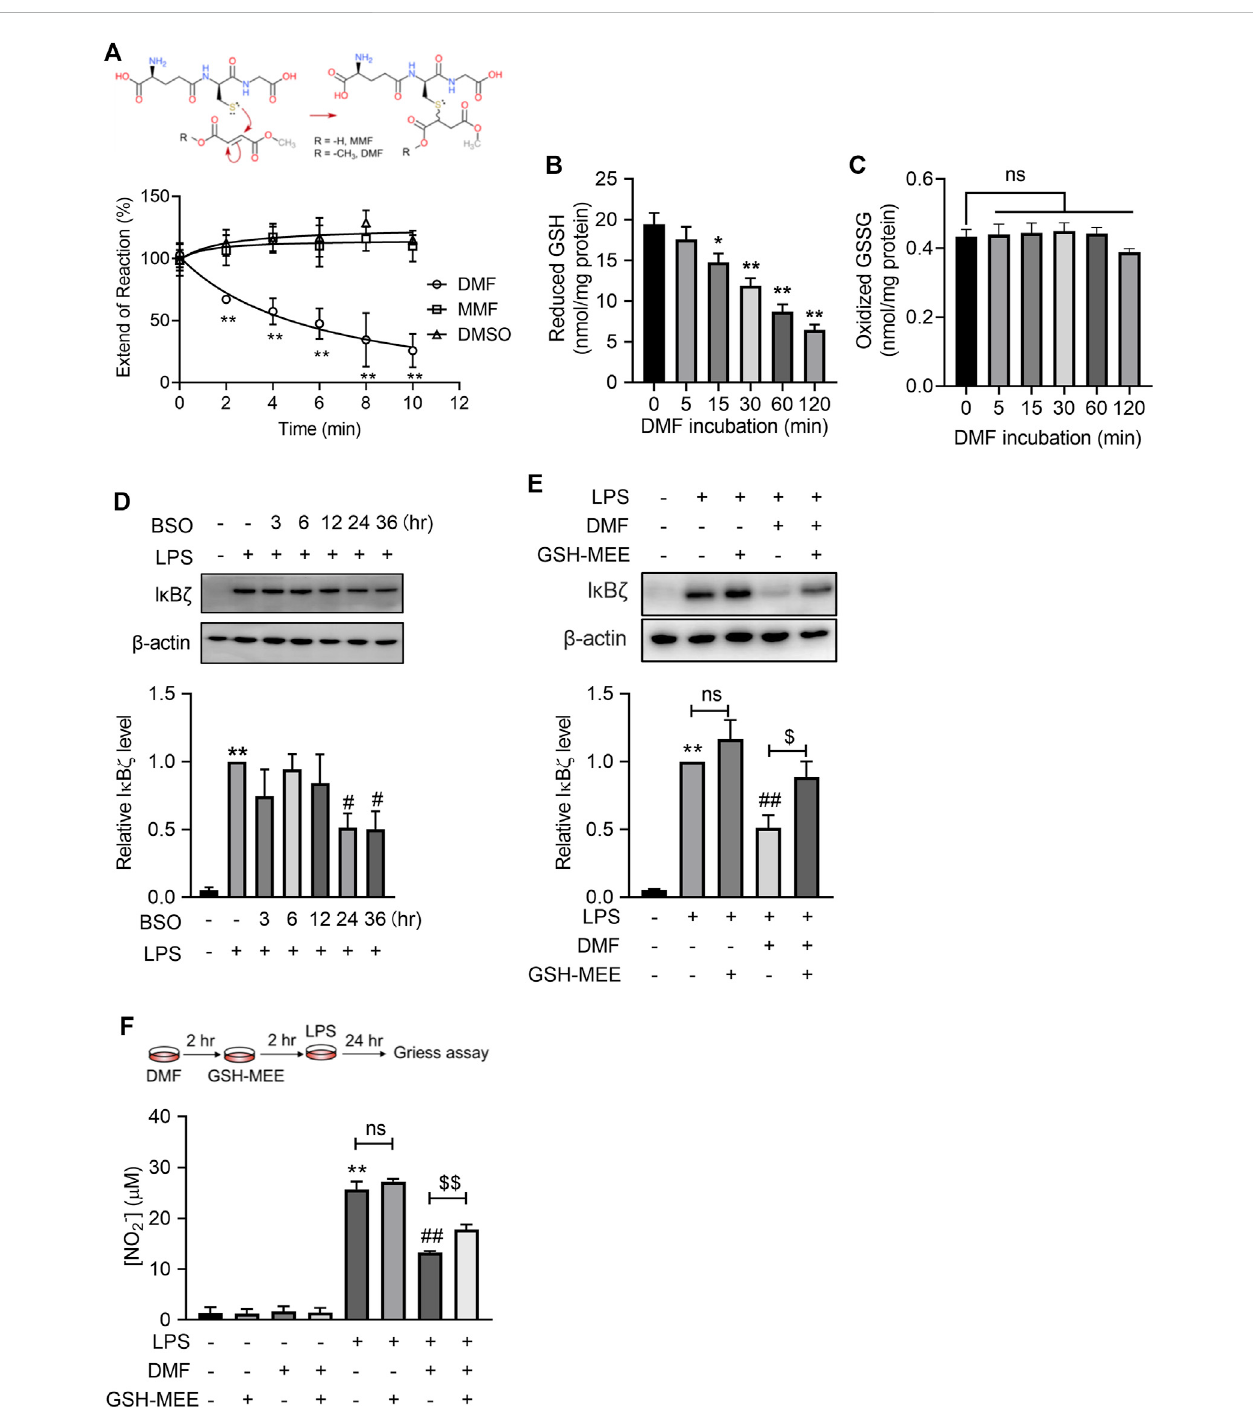
FIGURE 5 DMF suppressed LPS-induced I κ B ζ expression by rapid GSH depletion. (A) DMF or MMF (100 μ M) was incubated with 1 mM GSH under physiological conditions (37 ° C, pH = 7.4) and then monitored by Ellman ’ s assay ( n = 4). (B,C) RAW264.7 cells were treated with 40 μ M DMF for the indicated time and were thenharvestedforthedeterminationofintracellularGSH (B) andGSSG (C) . (D) RAW264.7cellsweretreatedwith100 μ MBSOfortheindicatedtimes.Western blot analysis and quanti fi cation of I κ B ζ in the indicated groups ( n = 3). (E) RAW264.7 cells were treated with 40 μ M DMF for 2 h and then supplied with 2 mMGSH-MEEintheabsence ofDMF,followedby1 hLPSstimulationintheabsenceofeitherGSH-MEEorDMF.Western blotanalysisandquanti fi cationof I κ B ζ in the indicated groups ( n = 4). (F) RAW264.7 cells were treated with 40 μ M DMF for 2 h and then supplied with 2 mM GSH-MEE in the absence of DMF, followed by a 24 h LPS stimulation in the absence of either GSH-MEE or DMF. The nitrite production from the indicated groups was quanti fi ed by the Griess assay ( n = 3). * p < 0.05 , ** p < 0.01 vs. the untreated group by one-way ANOVA; ## p < 0.01 vs. the LPS group by one-way ANOVA; $ p < 0.05 , $$ p < 0.01 vs. the indicated group by t -test; ns, not signi fi cant vs. the indicated group by t